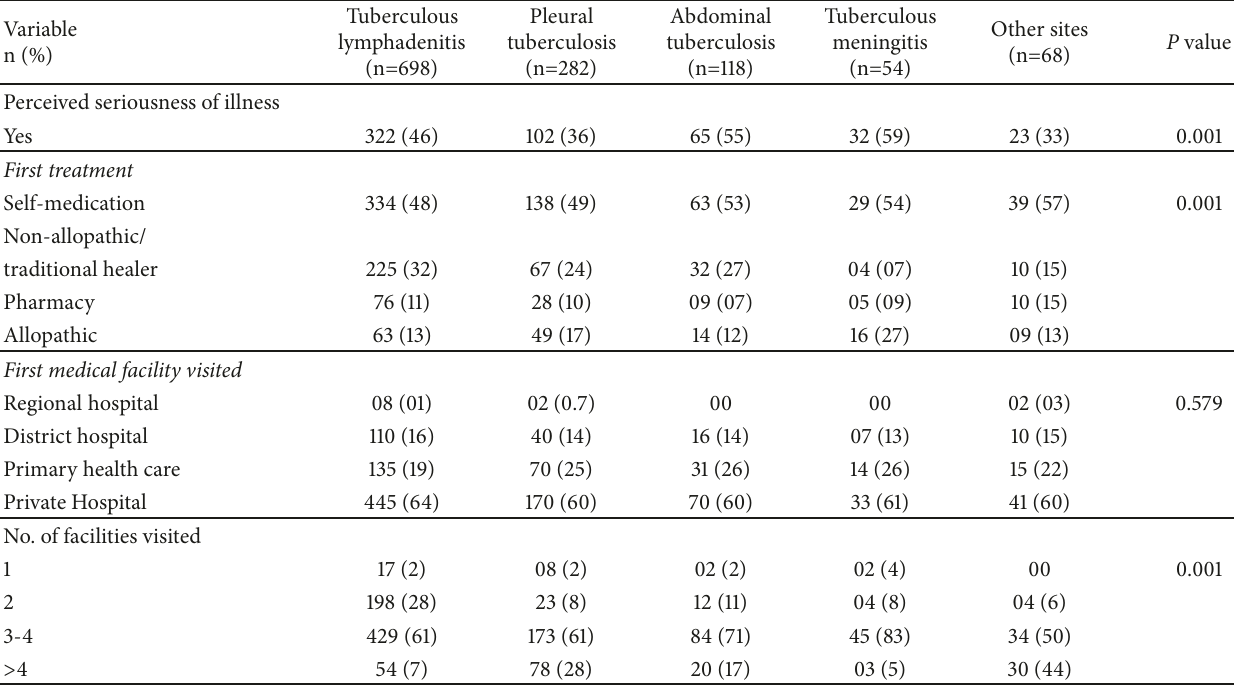
Table 3: Health seeking practices of patients with various forms of extrapulmonary TB (N=1220). Variable